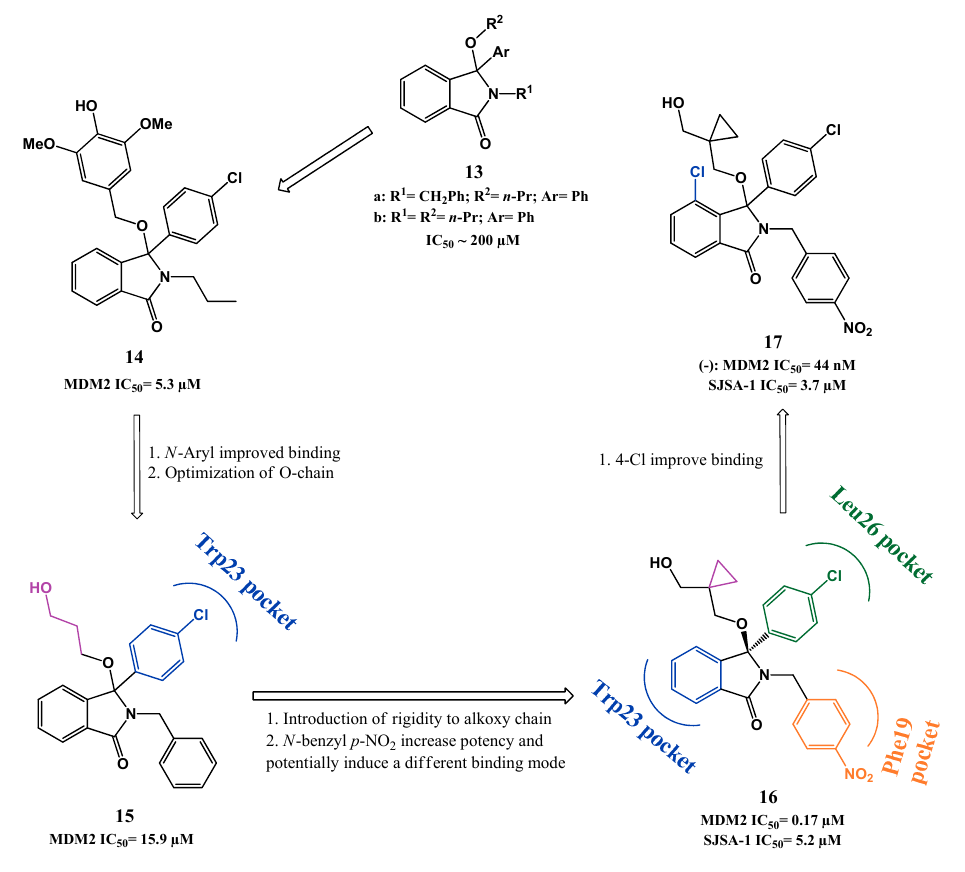
Figure 5. Isoindolinone scaffold optimization. Representations of binding modes were determined from chemical shift data and molecular docking [83,85].